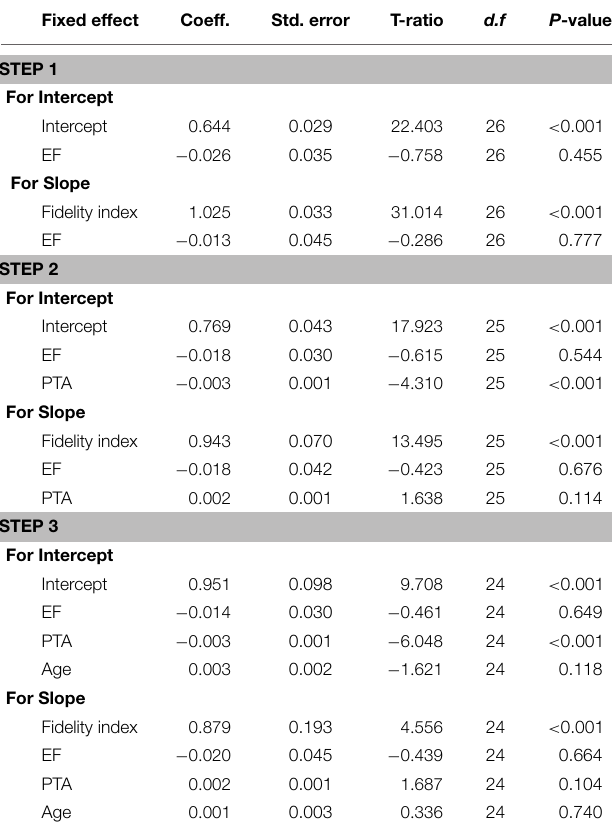
TABLE 3 | Summary of hierarchical linear model for intelligibility with executive function (EF) as a predictor. Fixed effect